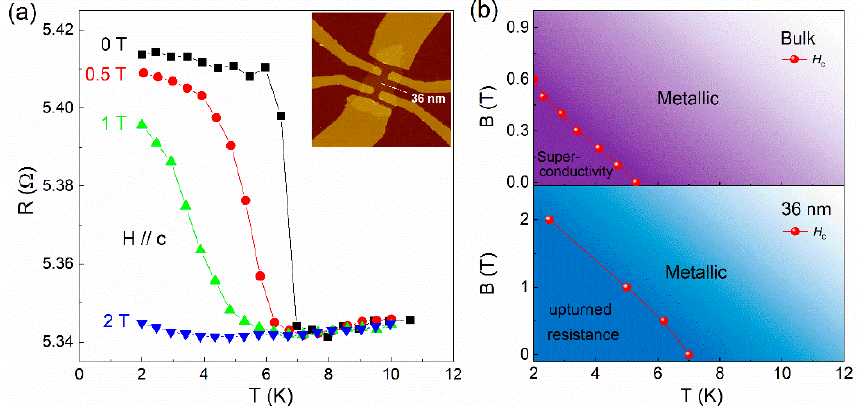
Figure 3. ( a ) Temperature dependence of resistance of β -PdBi 2 flake under different magnetic fields along c axis. Inset: AFM image of a fabricated β -PdBi 2 sample in a Hall-bar geometry. ( b ) The H c - T c phase diagram of bulk β -PdBi 2 (upper) and 36 nm nanoflake (below).